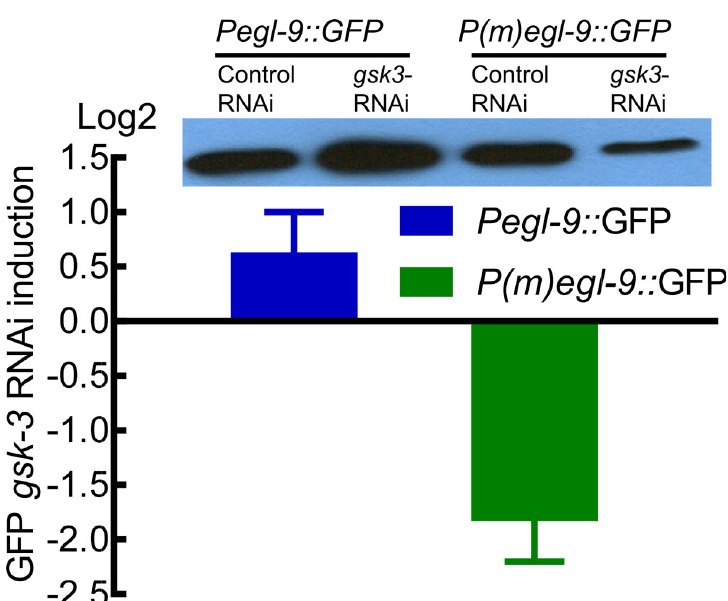
Fig 6. gsk-3 RNAi induction of Pegl-9 ::GFP. gsk-3 RNAi increased expression of Pegl-9 ::GFP, relative to control RNAi (the L4440 empty vector). This effect was dependent upon the putative SKN-1 binding site in the reporter (mutated in P(m)egl-9 :: GFP ). The figure shows the log2 fold change of GFP from four biological replicates, with standard errors. A representative western blot is shown. For each sample, 20 L4-stage worms were boiled and lysates corresponding to 10 worms were loaded to each lane.